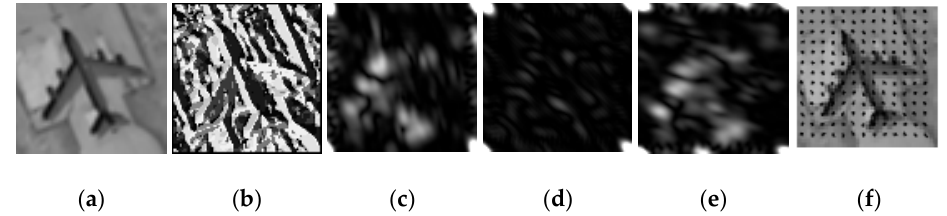
Figure 4. Multiple feature visualization results for airplane patch, where ( a ) denotes the original patch. The local binary pattern features (LBP) are displayed in ( b ). ( c – e ) denote the Gabor feature using Gabor filter with different orientations and scales, and ( f ) denotes the HoG feature.